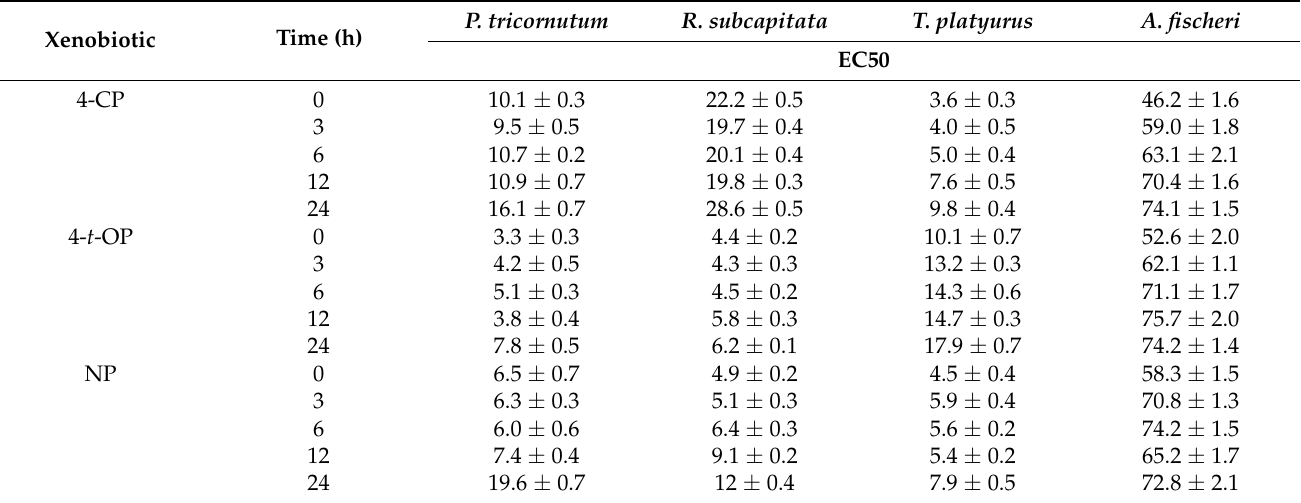
Table 1. Assessment of the acute toxicity effects of U. isabellina post-culture filtrates with the addition of 4-CP, NP, or 4- t -OP by using different bioindicator